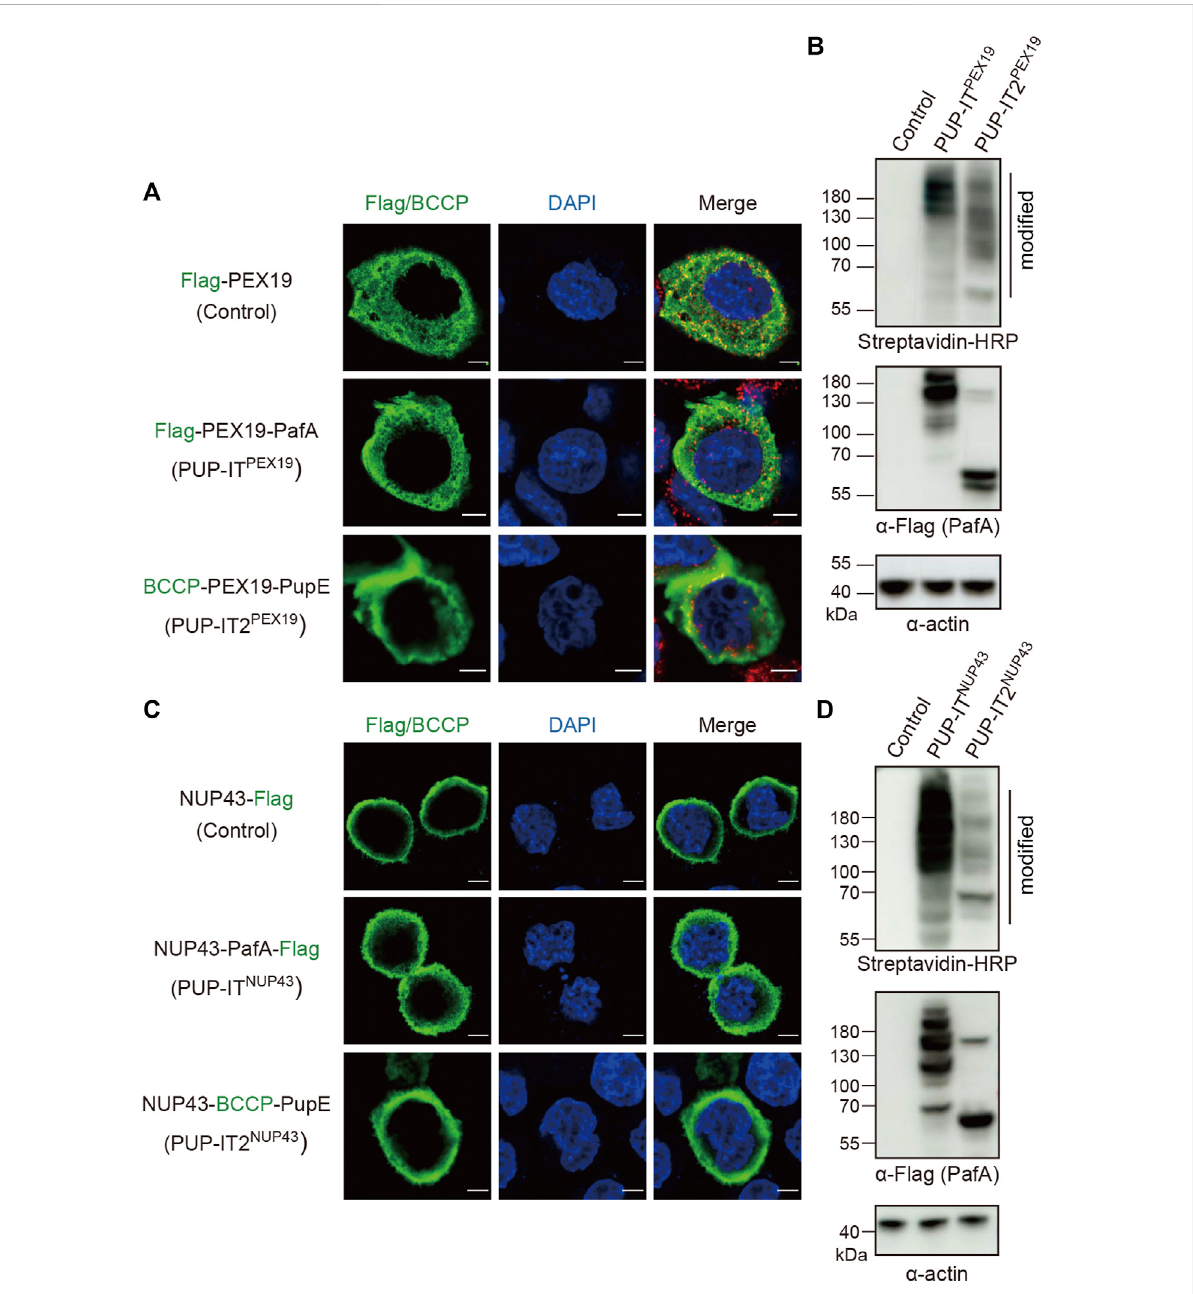
FIGURE 3 PUP-IT2 mediates proximity labeling in cells. (A) Immuno fl uorescence staining of HeLa cells transfected with Flag-PEX19, PUP-IT PEX19 (Flag- PEX19-PafA) or PUP-IT2 PEX19 (BCCP-PEX19-PupE). Cells were stained with anti-Flag or cy3-conjugated streptavidin (green), and the nucleus were stained with DAPI (blue). Scale bars, 5 μ m. (B) Immunoblots of ligated proteins in HEK293 cells transfected with empty vectors (control), PUP-IT PEX19 (Flag-PEX19-PafA, BCCP-PupE) or PUP-IT2 PEX19 (BCCP-PEX19, Flag-PafA). HRP-conjugated streptavidin and other indicated antibodies were used for western blots. (C) Immuno fl uorescence staining of HeLa cells transfected with NUP43-Flag, PUP-IT NUP43 (NUP43-PafA-Flag) or PUP- IT2 NUP43 (NUP43-BCCP-PupE). Cells were stained with anti-Flag/cy3-conjugated streptavidin (green) antibodies, and the nucleus were stained with DAPI (blue). Scale bars, 5 μ m. (D) Immunoblots of ligated proteins in HEK293 cells transfected with empty vectors (control), PUP-IT NUP43 (NUP43- PafA-Flag, BCCP-PupE) or PUP-IT2 NUP43 (NUP43-BCCP-PupE, Flag-PafA). HRP-conjugated streptavidin and other indicated antibodies were used for western